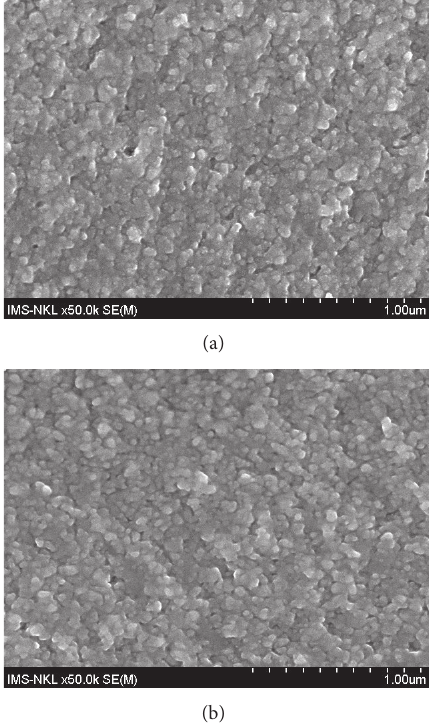
Figure 3: FESEM micrograph of the as-spun Nd 16 Fe 76 B 8 /40% wt. = 34 m/s without the assisted magnetic Fe 65 Co 35 ribbons: (a) V opt = 30 m/s in the magnetic field 0.32 field and (b) V opt